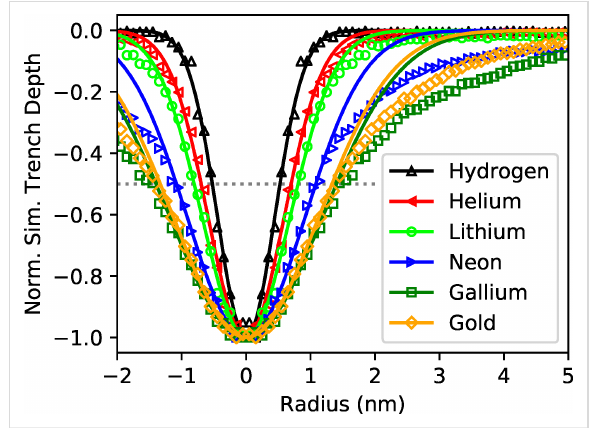
Figure 5: SRIM simulation [39] of the sputter profile from a 30 keV point-like beam in a gold substrate as a function of the ion mass. The dotted line denotes 50% trench depth and corresponds to the minimum milling width of a point-like ion beam.